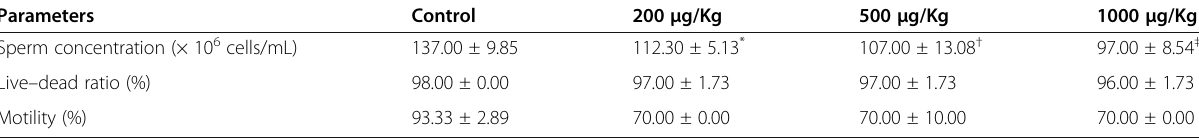
Table 1 Effect of dichloromethane fraction of Waltheria indica Linn . root on sperm parameters of male Wistar rats (Mean ± SD, n = 5 for each group)